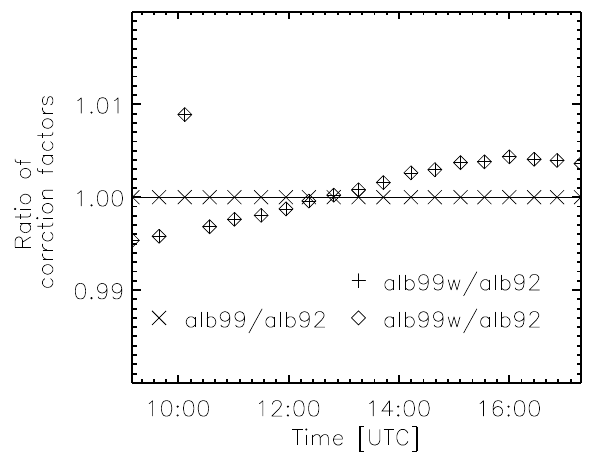
Fig. 2. Ratios of correction factors modelled with different input albedos for an example day. The abbreviations used in the leg- end represent the type of albedo and cloud input parameter for UVSPEC: alb92: albedo 0.92, no clouds; alb99: albedo 0.99, no clouds; alb92w: albedo 0.92, stratiform cloud cover; alb99w: albedo 0.99, stratiform cloud